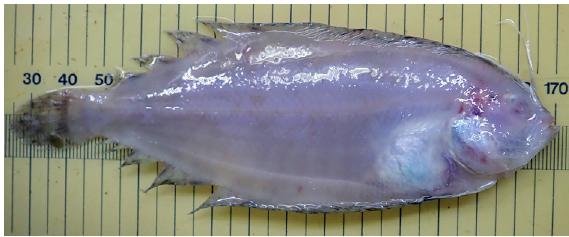
Fig. 11. – Arnoglossus imperialis Rafinesque, 1810, SMNS 27385, one male, 101.0 mm SL, southeast of Menorca, 133 m depth. Photograph of fresh specimens taken by Francesc Ordines. Blind